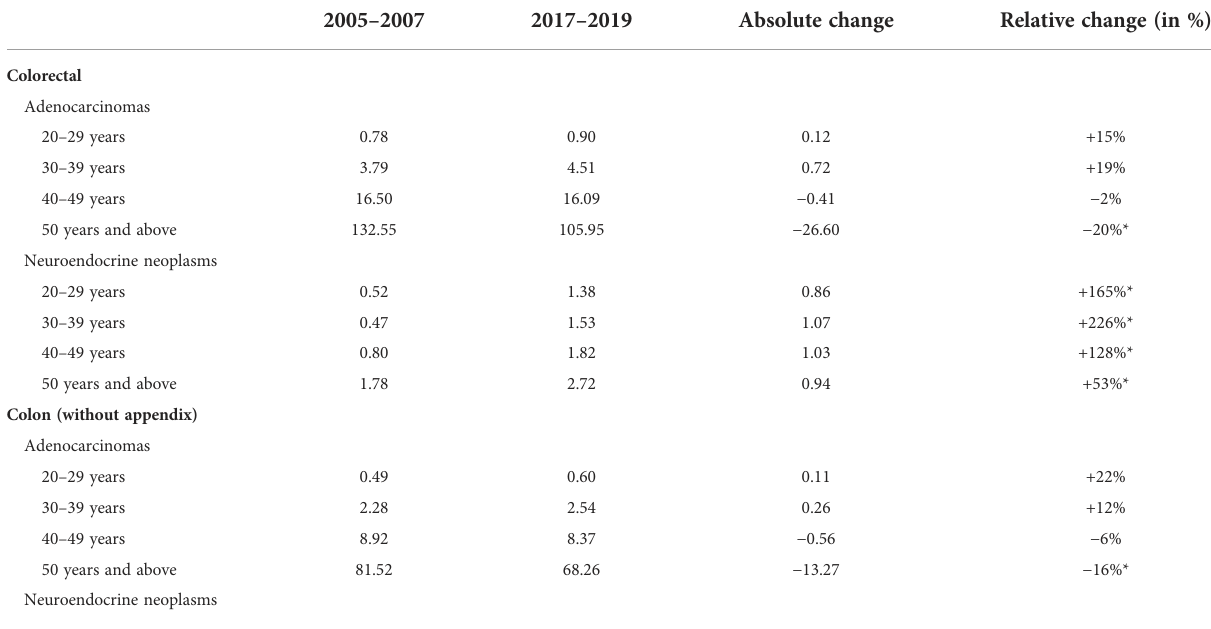
ASIR per 100,000 persons